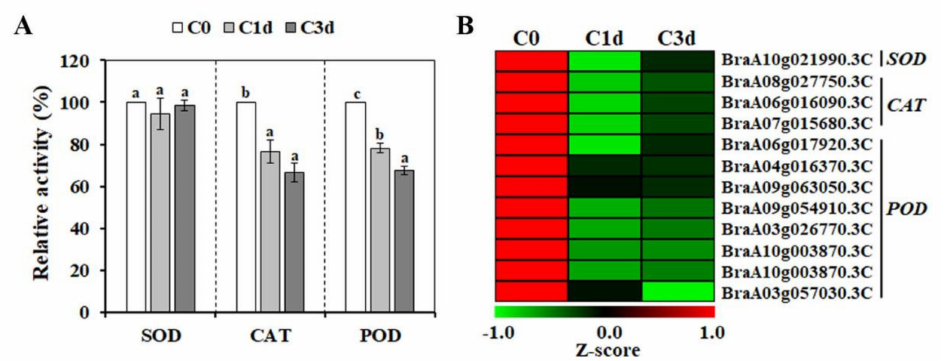
Figure 4. Effect of cold stress on the activity of antioxidant enzymes ( A ) and cold-induced differen- tially expressed genes encoding antioxidant enzymes ( B ). The data are presented as mean ± SE of five independent experiments. Values with different letters are significantly different, according to Duncan’s multiple range test. Red and green colors indicate ascending and descending Z-scores, respectively. C0, plants grown at 20 ◦ C (control plants); C1d and C3d, plants subjected to cold stress (10 ◦ C) for 1 day and 3 days,